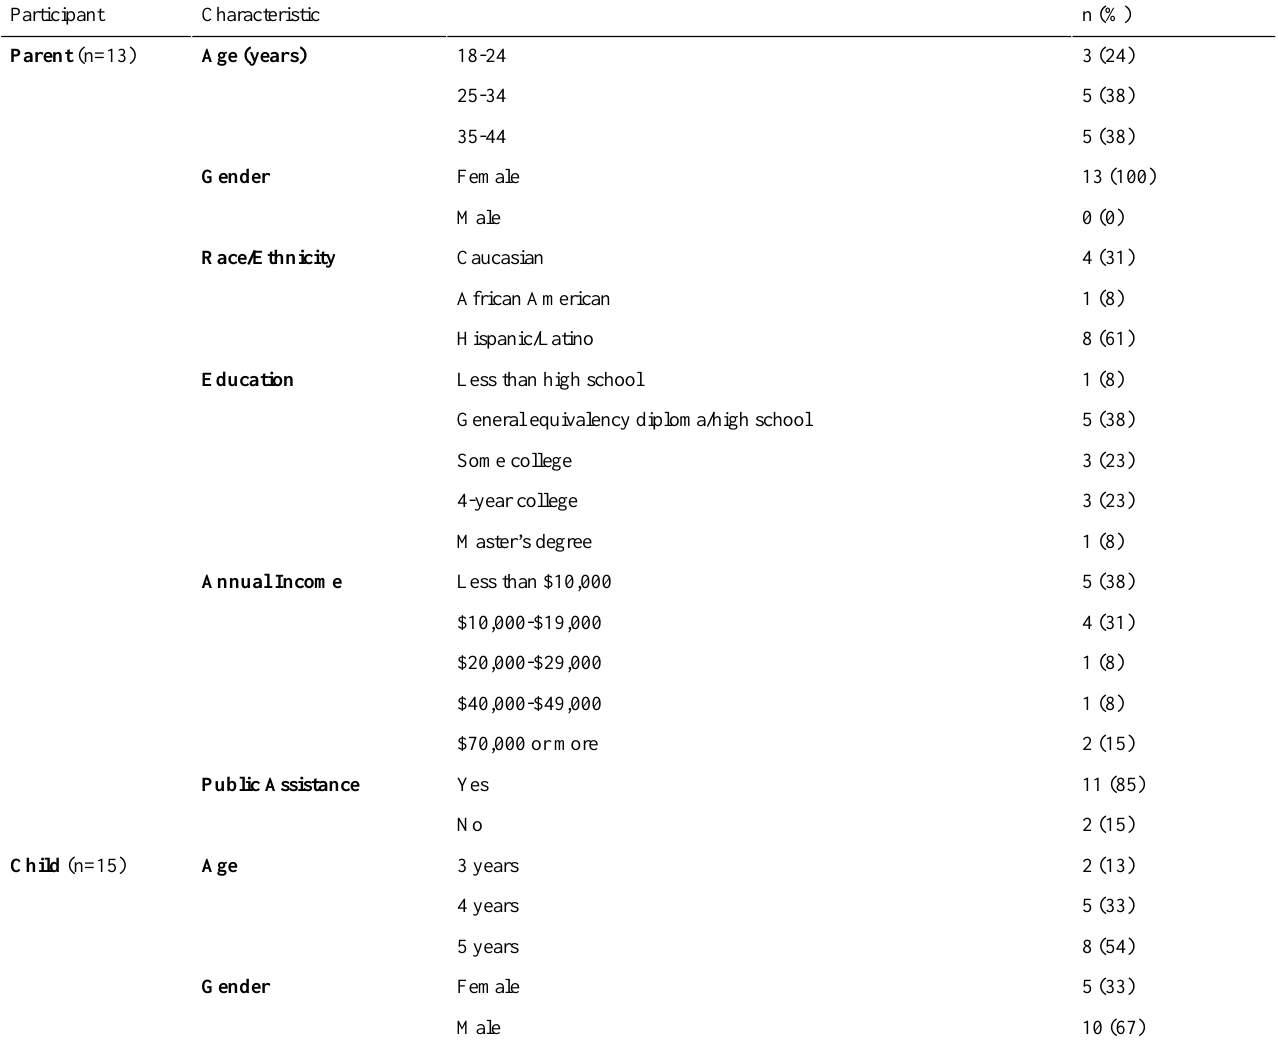
Table 4. Descriptive characteristics of TEXT2COPE parents and